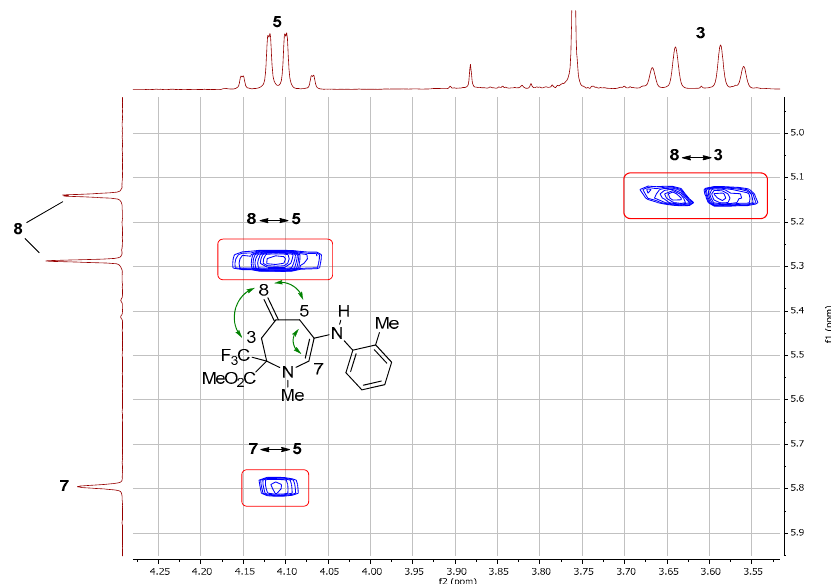
Figure 2. A fragment of 2D 1 H ROESY NMR spectrum (500 MHz, CDCl 3 ) of 3d .